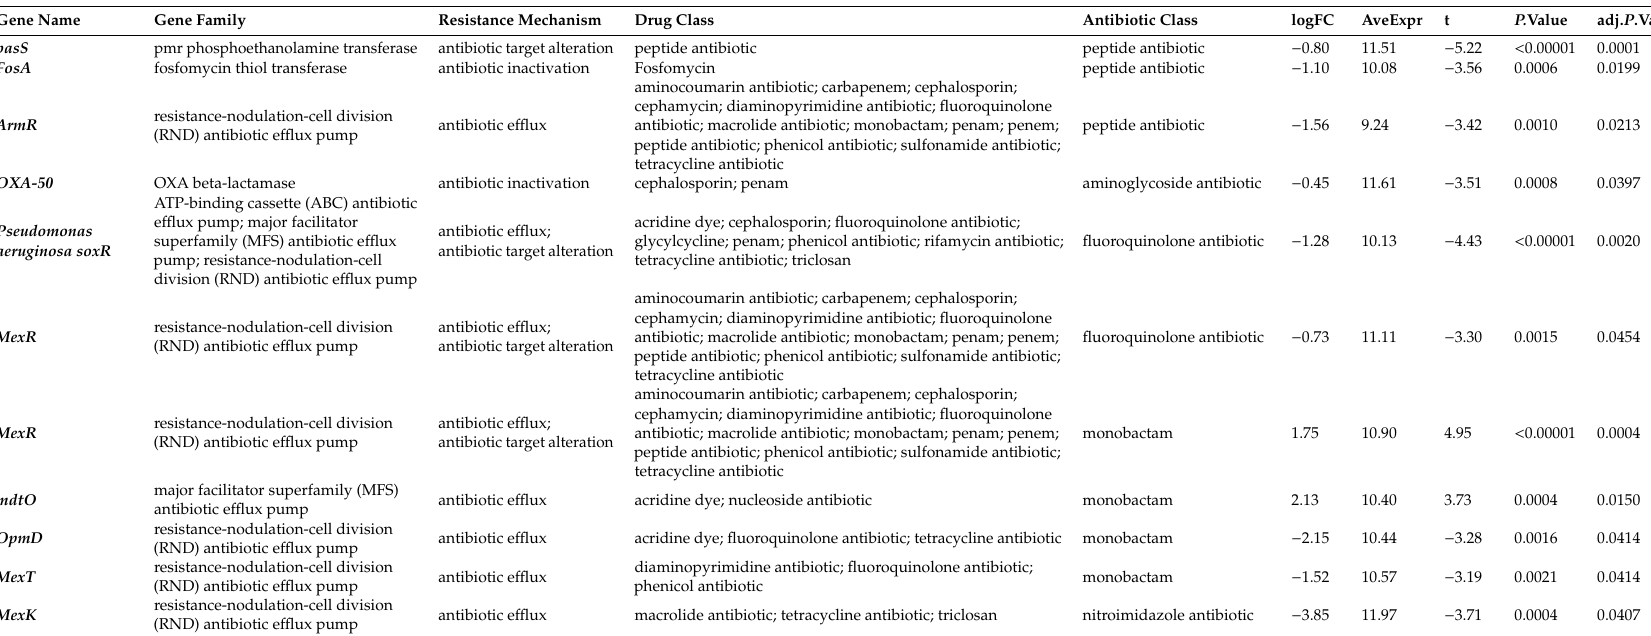
Table 3. Antibiotic resistance genes di ff erentially distributed depending on drug